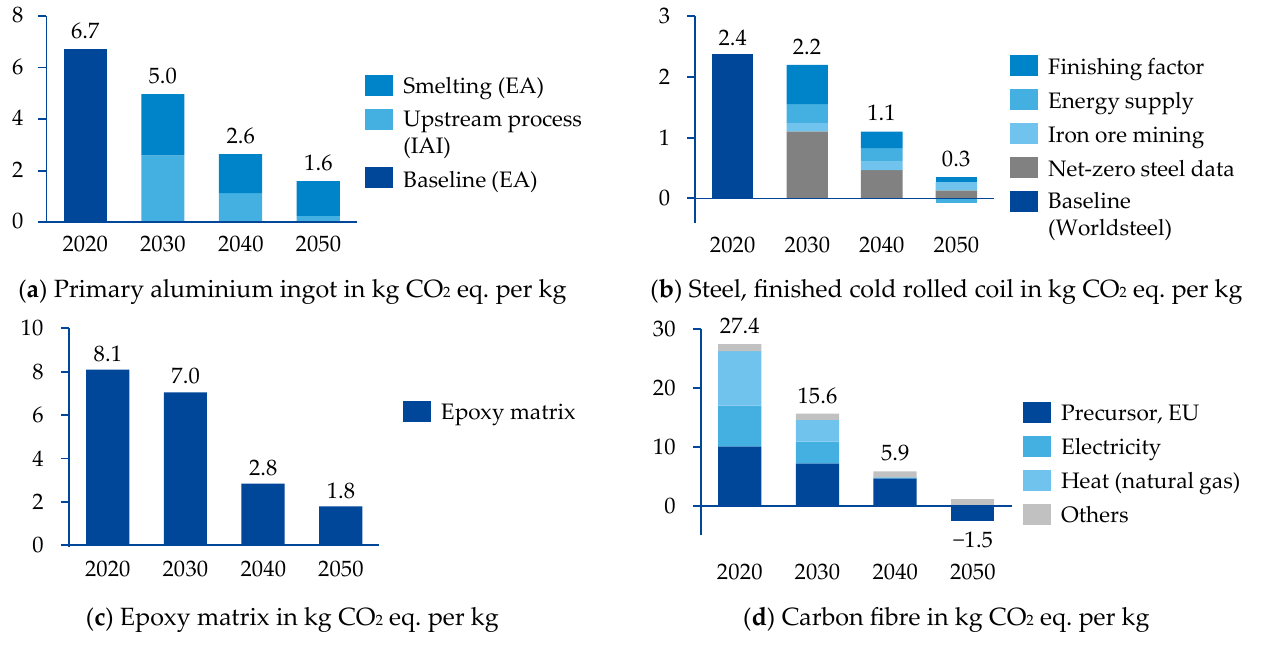
Figure 8. Emission intensity in kg CO 2 eq. for the production of major materials per kilogram material—future projections until 2050: ( a ) projection for primary aluminium ingot based on [39,40,61]; ( b ) projection for steel, fi nished cold-rolled coil based on [37,38,60,72]; ( c ) projection for epoxy matrix based on [64,73]; ( d ) projection for carbon fi bre based on [14–16,41,43,62,73].